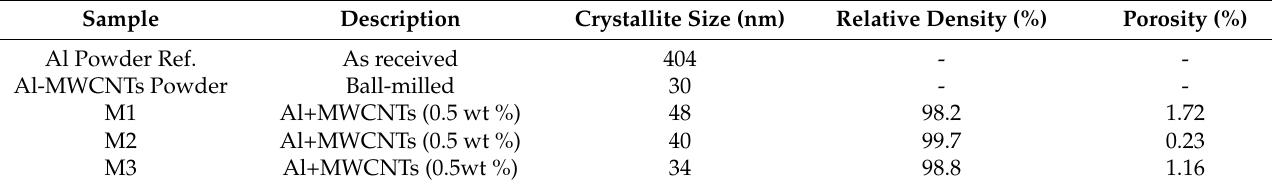
Table 1. Crystallite size, relative density and porosity percentage calculated for samples M1, M2, M3, Al powder, and ball-milled Al-MWCNTs powder. Sample Description Crystallite Size (nm) Relative Density (%) Porosity (%) Al Powder